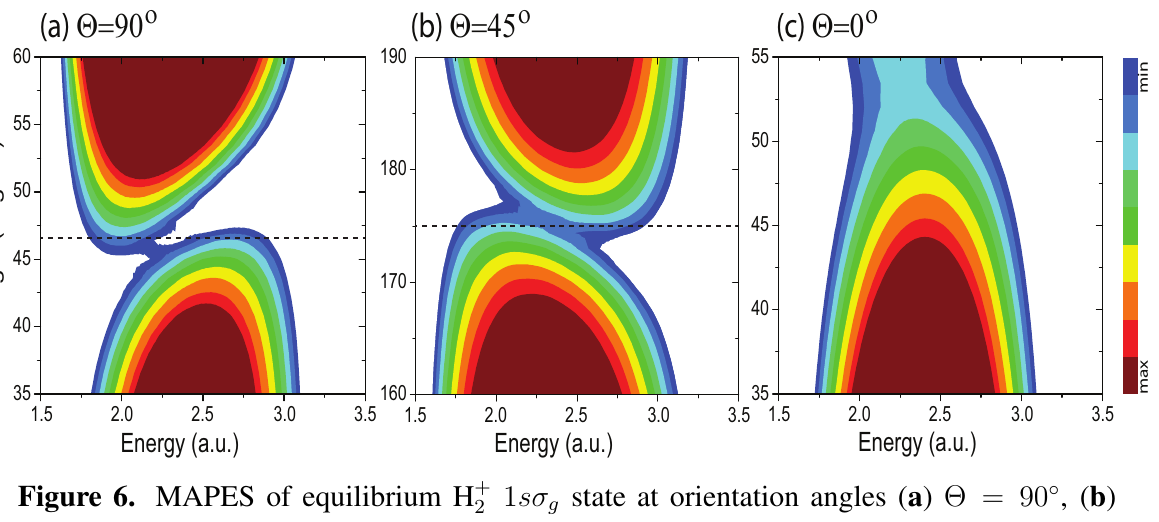
Figure 6. MAPES of equilibrium H + Θ = 45 ◦ , and ( c ) Θ = 0 ◦ with intense I polarized attosecond XUV laser pulses. Signal intensities of the ionization spectra are on a logarithmic scale in arbitrary